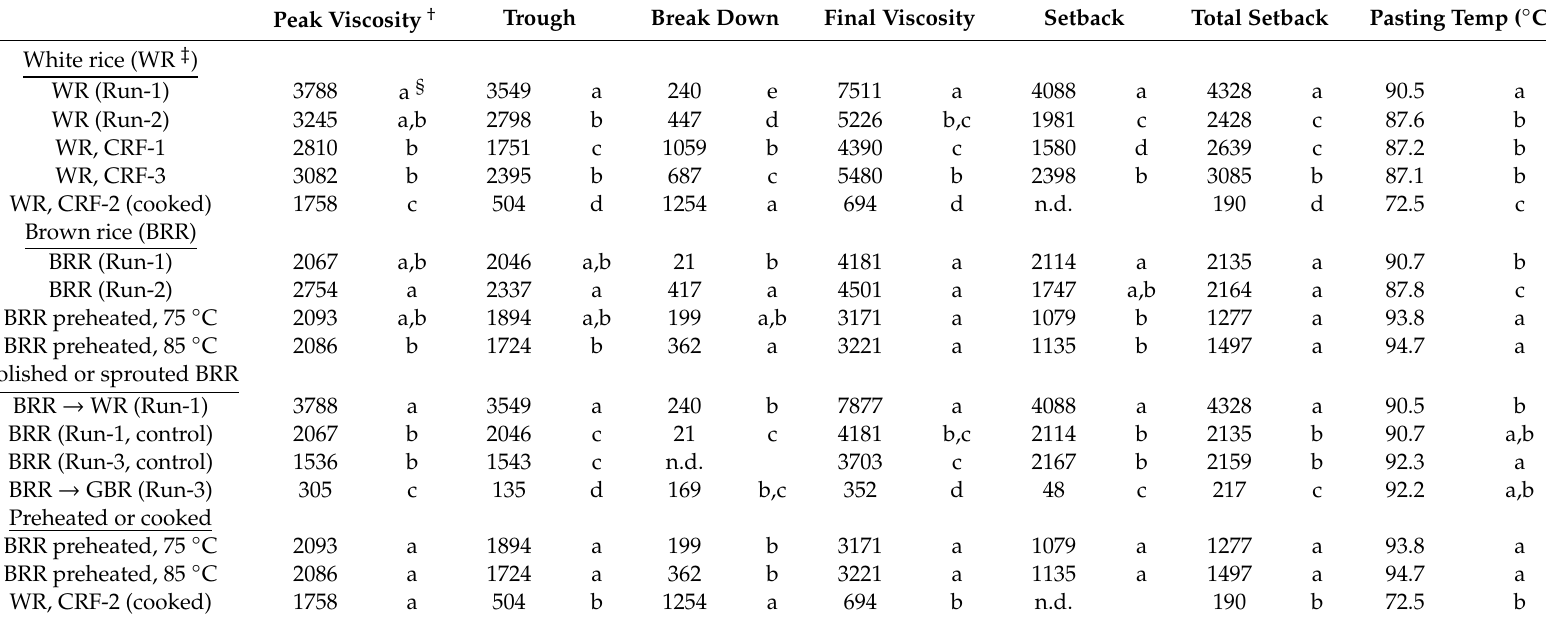
Table 1. Rapid visco-analyzer (RVA) results illustrating freshly prepared Rondo rice flours: white rice, brown rice and germinated brown rice, and commercial samples with “cooked” and “preheated” temperature e ff